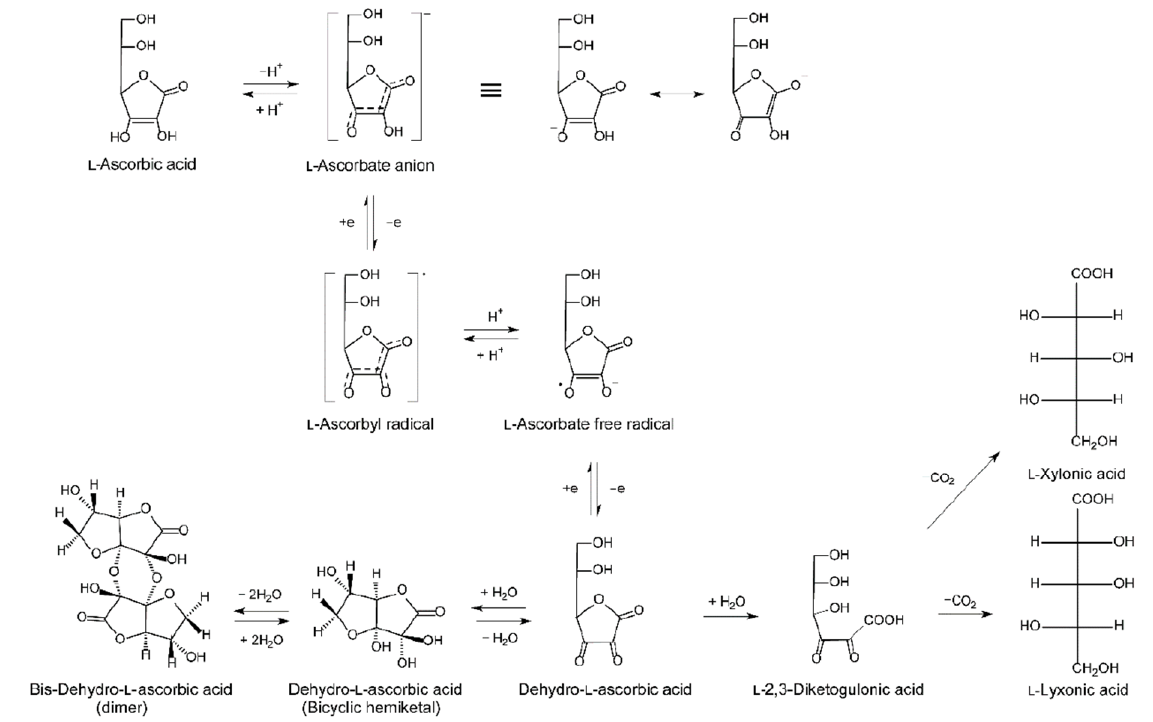
2.2. Cellular Vitamin C Efflux Figure 1. Schematic outline of ascorbic acid oxidation and nomenclature. Ascorbate (ASC) readily quenches free